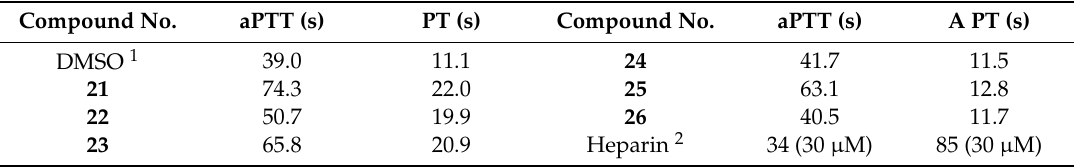
Table 5. Anticoagulant activities of amidine compounds 21 – 26 at 30 µ g/mL. Compound